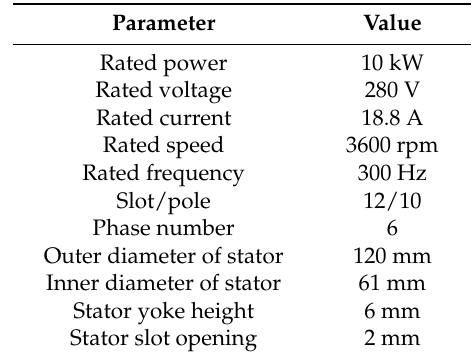
Figure 1. The stator profile: ( a ) dual-redundancy permanent magnet synchronous motor; ( b ) the traditional permanent magnet synchronous motor without small teeth. Table 1. The main parameters.